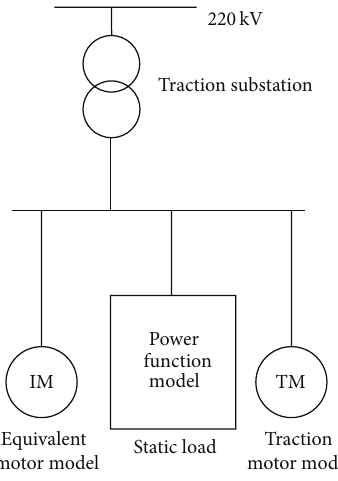
Figure 2: The structure diagram of